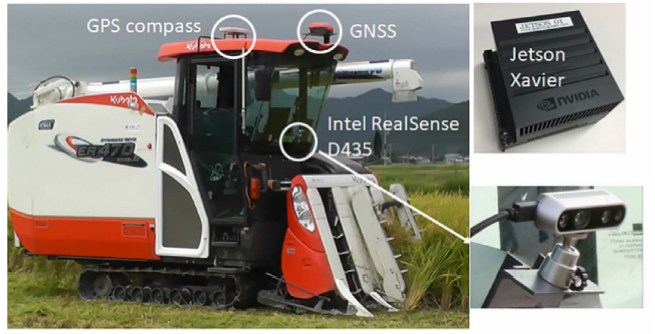
Figure 11. Robotic combine harvester and installed devices